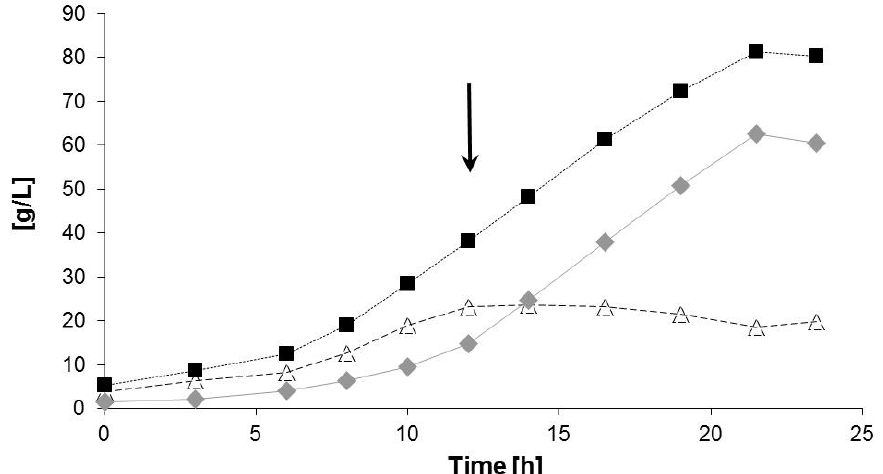
Figure 2. Pattern of product formation during the bioreactor fermentation: Cell dry mass (CDM, black squares), residual biomass (Xr, white triangles), and PHA (grey diamonds). The arrow indicates the stop of nitrogen (NH 4+ ) supply to provoke PHA biosynthesis, and the start of LW-addition.